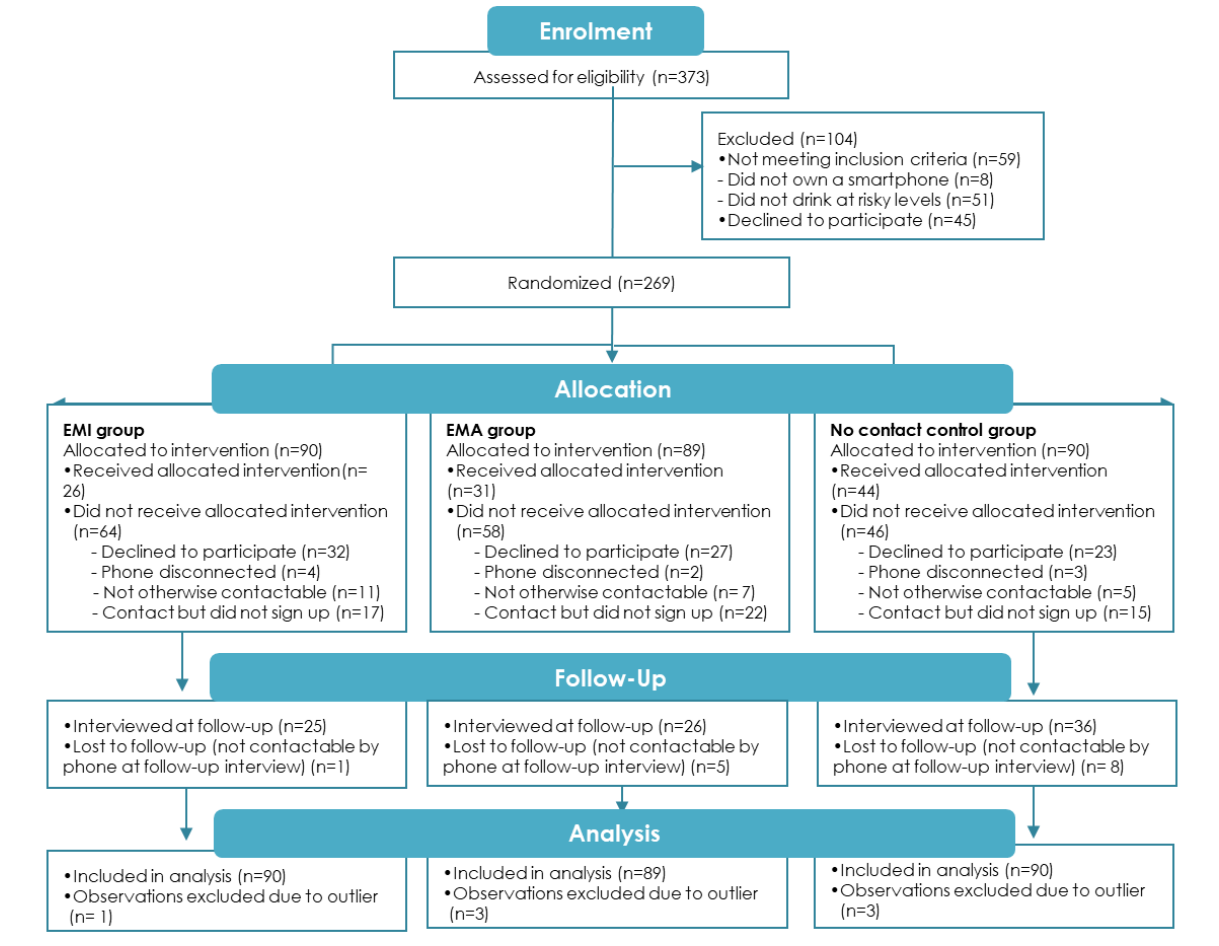
Figure 1. CONSORT